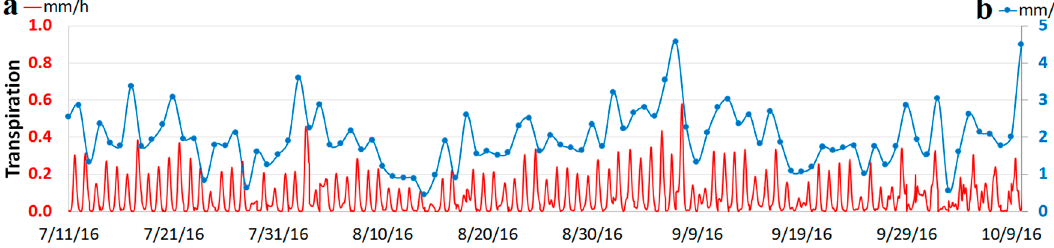
Figure 10. Transpiration ( τ ) calculations in the ASWP site based on the measurements in nodes 2014, 2034 and 2134, from 11 July 2016 (7/11/16) to 11 October 2016 (10/11/16). ( a ) Transpiration rates in mm/h based on a 10-min interval; ( b ) Transpiration rates in mm/day based on a 24-h interval. Integrating the hourly τ rates in Figure 10a to monthly totals yields 40.8 mm from 11 to 31 July, 55.2 mm from 1 to 31 August, 65.4 mm from 1 to 30 September, and, 30.7 mm from 1 to 11